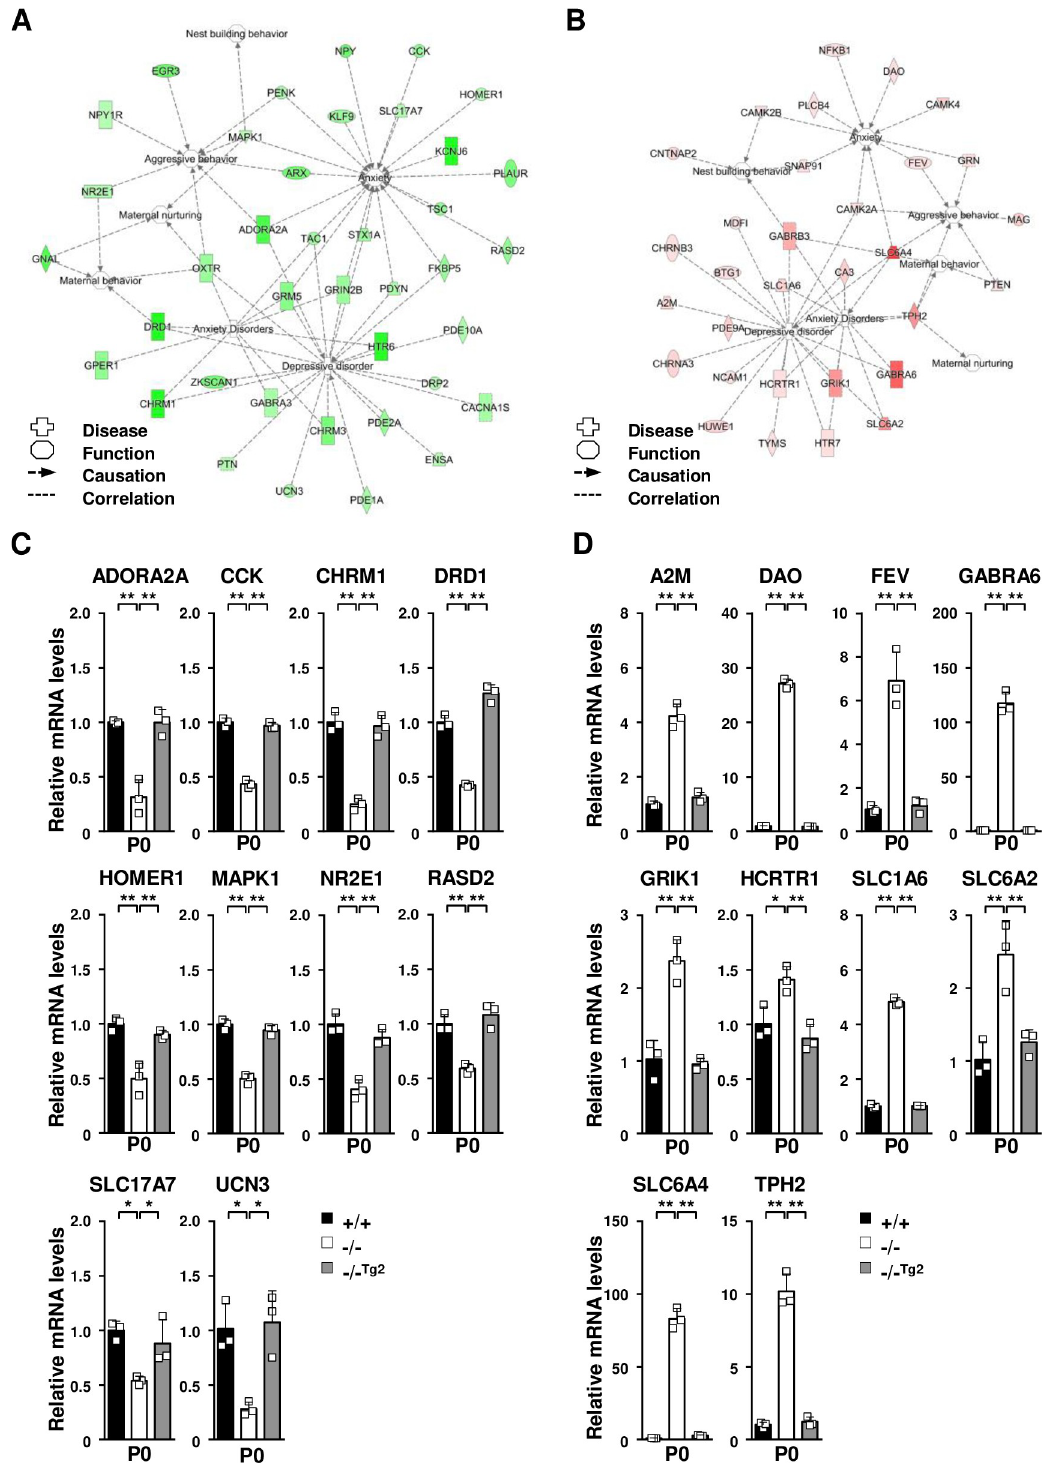
Fig 6. Altered gene expression in the brain tissue of TDAG51 -/- dams after parturition. (A) Prediction of the functional networks of the 39 downregulated genes listed in Table 1. Node color intensity indicates the degree of the downregulation of gene expression as follows: a greater intensity of green represents a higher degree of downregulation. Inverted triangle, kinase; dotted square, growth factor; vertical rectangle, G-protein coupled receptor; dotted vertical rectangle, ion channel; horizontal rectangle,